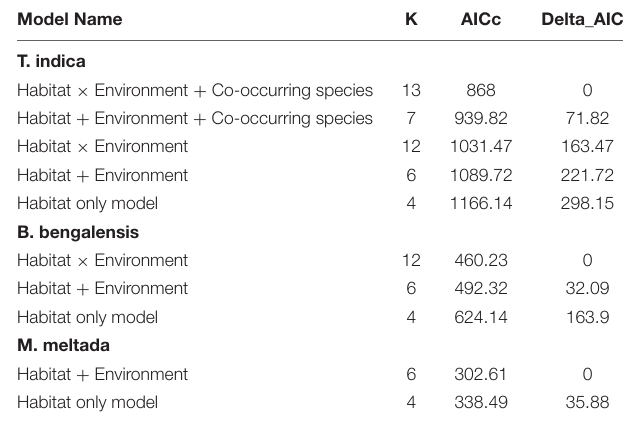
TABLE 4 | Generalized linear model (GLM) ranked based on AICc values for each